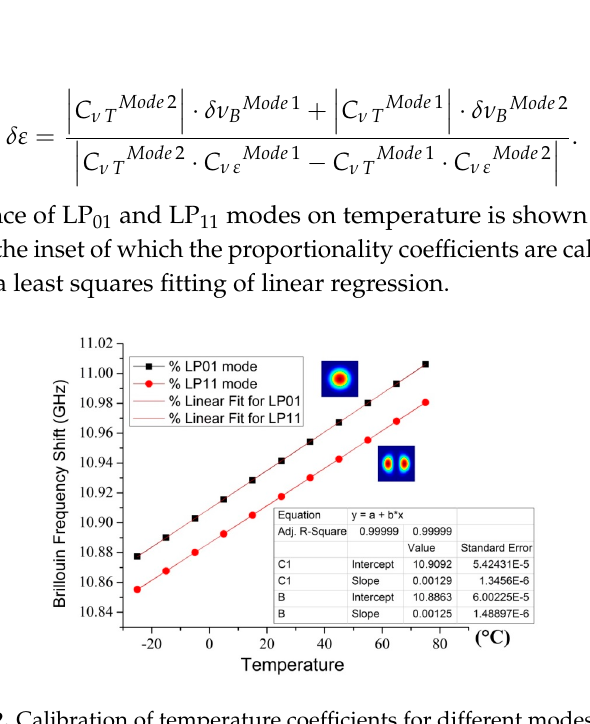
Figure 14. Signal-to-noise ratio (SNR) comparison for FM-BOTDR system between LP 01 and LP 11 mode along the sensing fiber.